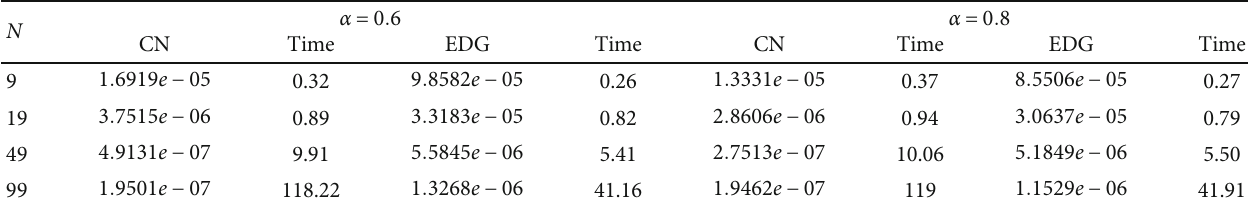
N = 49 , and Δ t = 0 : 01 in di ff erent values of t are illustrated.